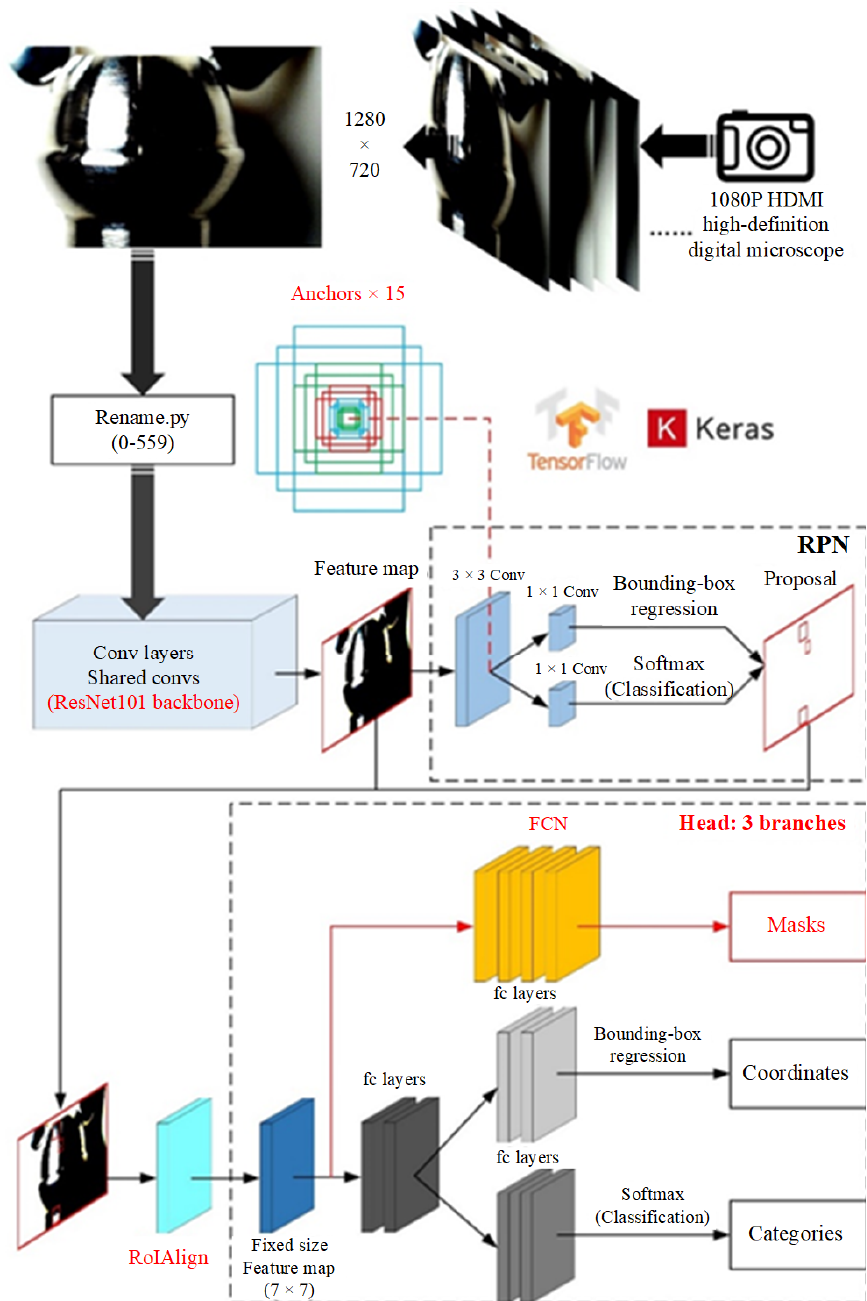
Figure 3. Defect detection flowchart of automotive engine parts.